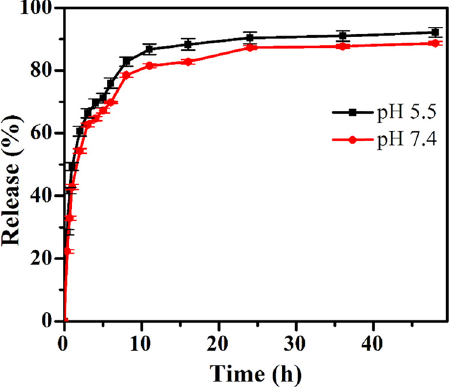
Figure 8: Time - dependent TMZ releasing pro fi les of CTF – TMZ at pH values of 5.5 and